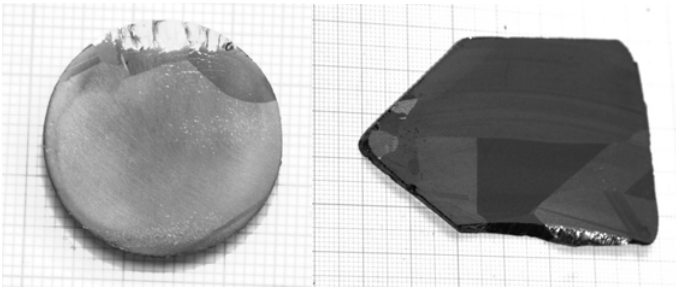
Figure 12. Large single grain wafers for 1-inch (left) and 2-inch (right) crystals.